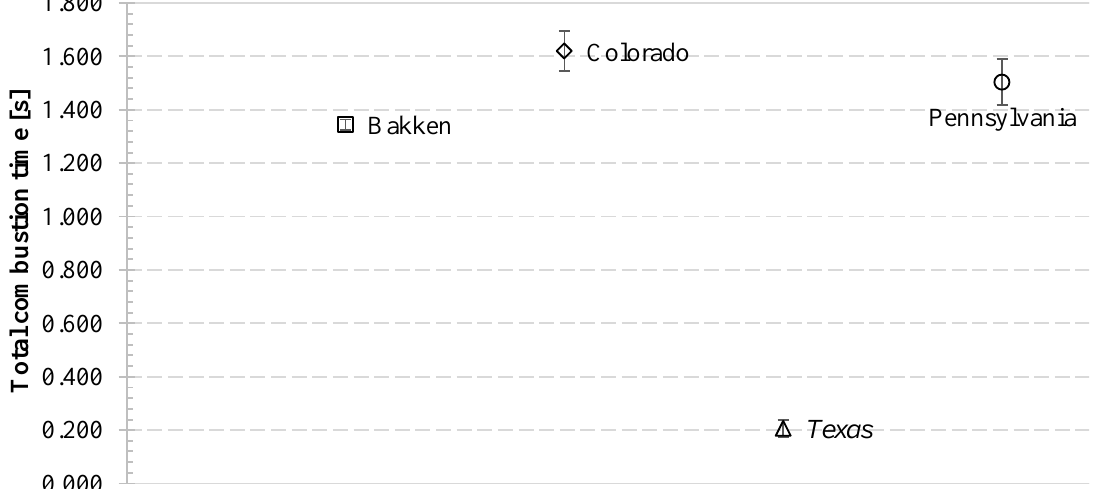
Figure 13. Average total combustion time of different crude oils.